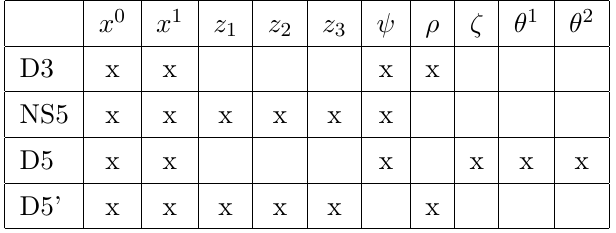
-BPS brane intersection T-dual to the brane intersection depicted in table 5. ( x 0 , x 1 ) Table 7 . 1 8 are the directions where the field theory lives, ( z ) span a T 3 , ψ is the T-duality circle and ρ 1 , z 2 , z 3 is the field theory direction. This configuration is S-dual to the configuration in table